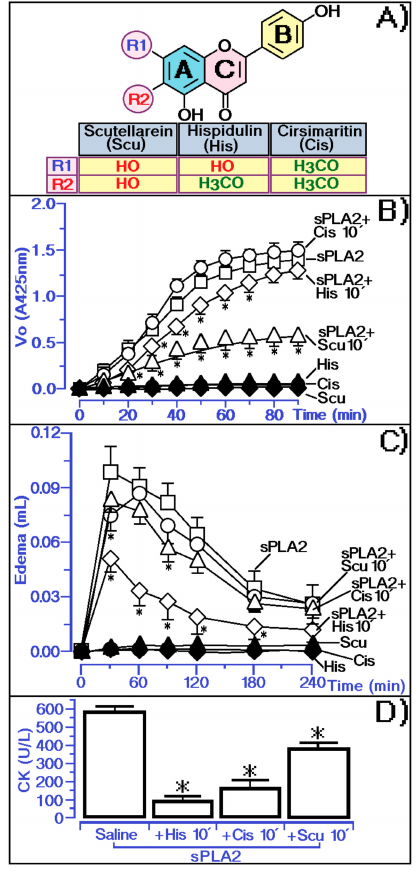
Figure 6. Analysis of the methyl and hydroxyl group on the protective function of hispidulin in inhibiting sPLA2-induced edema and myonecrosis and influences of these groups on the inhibition of sPLA2 enzymatic activity. ( A ) showed the structure of Hispidulin compared to Scutellarein (Scu) and Cirsimaritin (Cis). ( B ) Comparative analysis of His, Scu and Cis on phospholipase A2 enzymatic activity, where saline represents the control group. The results are expressed as a variation of enzymatic velocity Vo. ( C ) show paw edema induced after the injection of sPLA2 and sPLA2 treated with His, Cis and Scu, respectively, into the right paws of Swiss mice. Edema is expressed as volume in µ L and measurements were performed after 30, 60, 120, 180, and 240 min. ( D ) show the myonecrosis assay and the results are expressed as creatine kinase (CK) units of enzymatic activity per liter (U / L). Error bars indicate the SEM; * p ≤ 0.05 compared with the saline